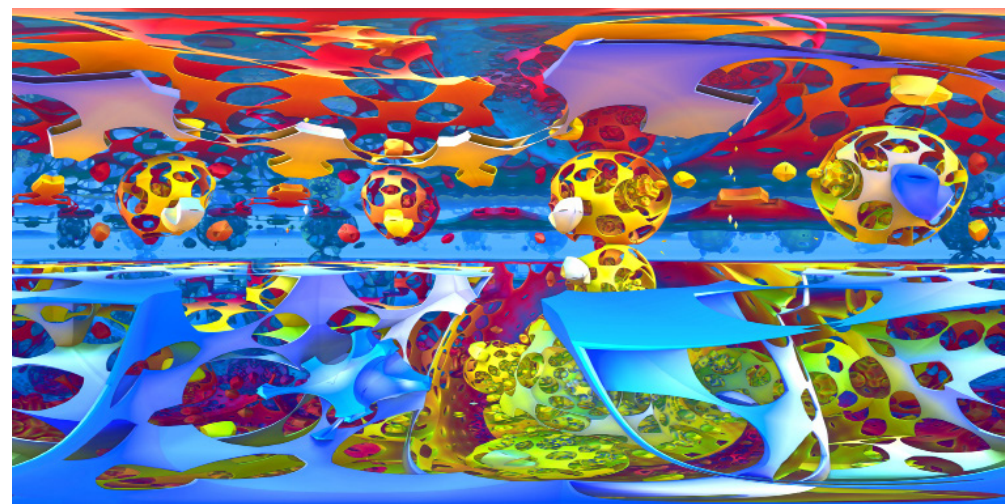
Fig. 4 In this equirectangular 3D illustration the many shapes and bright colors can generate a fear of missing out (FOMO) in the viewer due to the richness of detail and potential POIs.